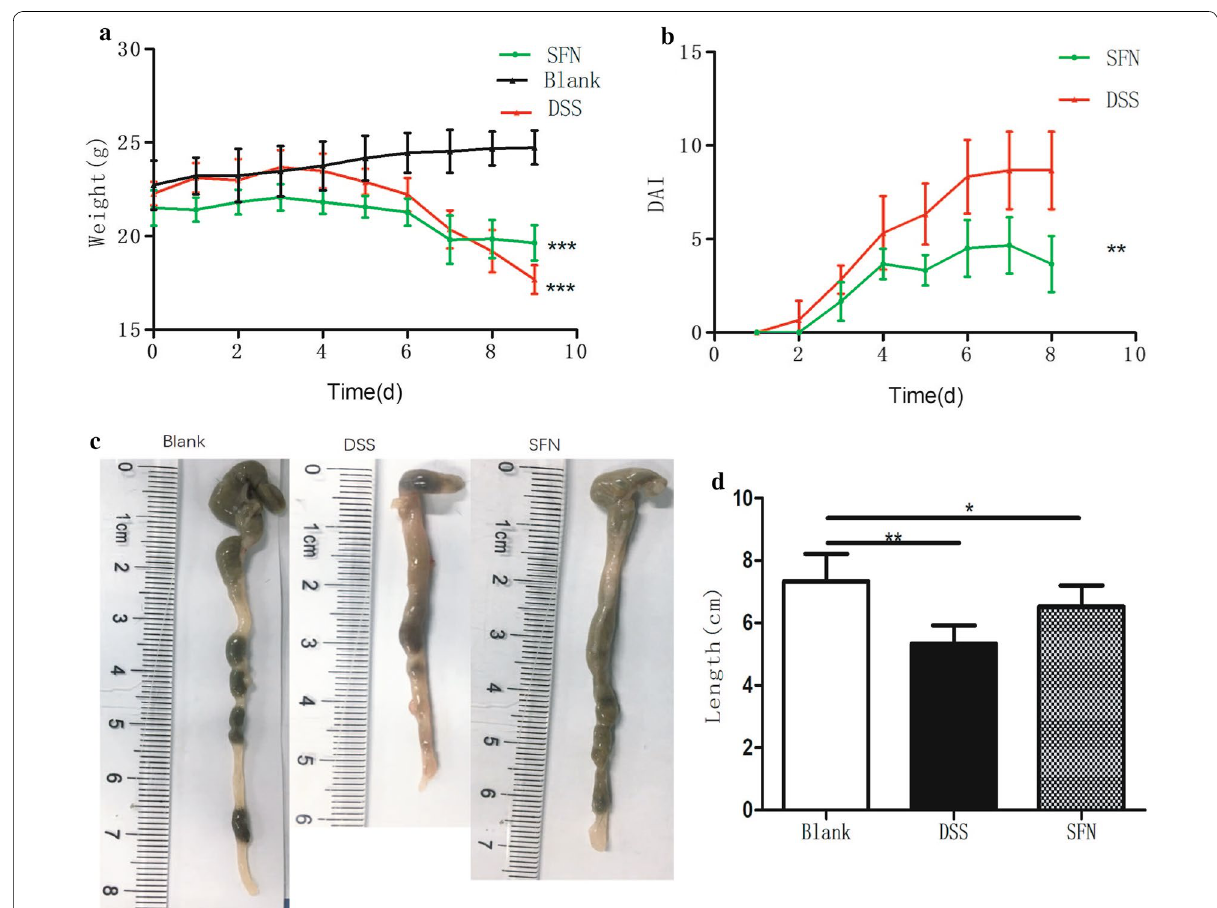
Fig. 1 Effects of Sulforaphane (SFN) on clinical signs in DSS-induced colonitis. (n of body weight in mice. b Disease activity index score in the SFN and DSS groups. c , d Effect of SFN on DSS-induced colon shortening. *P < 0.05, **P < 0.01, ***P <